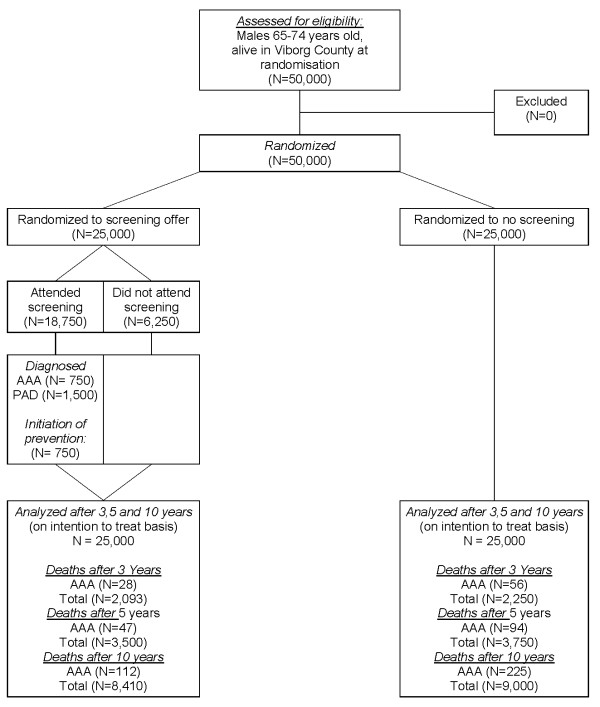
Expected flow-chart concerning vascular screening (VIVA) for peripheral arterial disease, abdominal aortic aneurysm and hypertension.